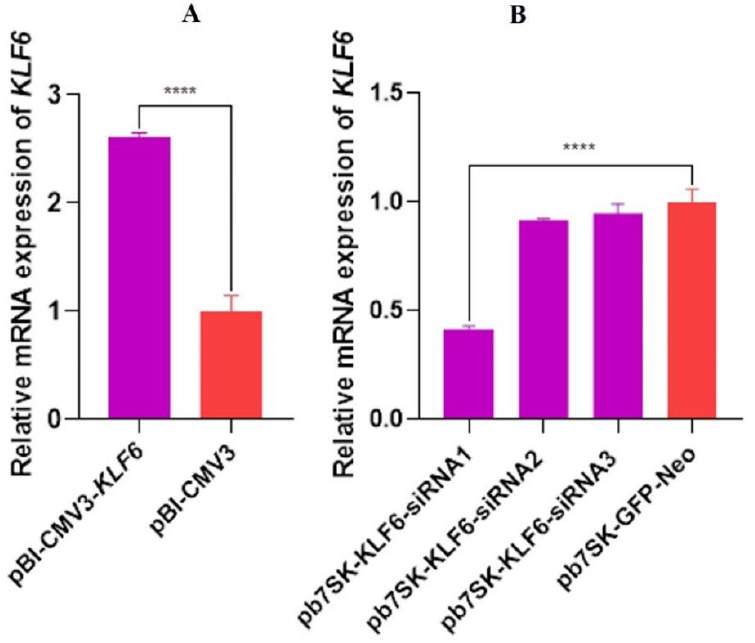
Figure 7. ( A ) Relative expression of KLF6 mRNA in BMECs transfected with pBI-CMV3- KLF6 and pBI-GFP-Neo-CMV3. ( B ) Relative expression of KLF6 mRNA in BMECs transfected with pb7SK- KLF6 -siRNA1, pb7SK- KLF6 -siRNA2, pb7SK- KLF6 -siRNA3, and pb7SK-GFP-Neo. **** p <